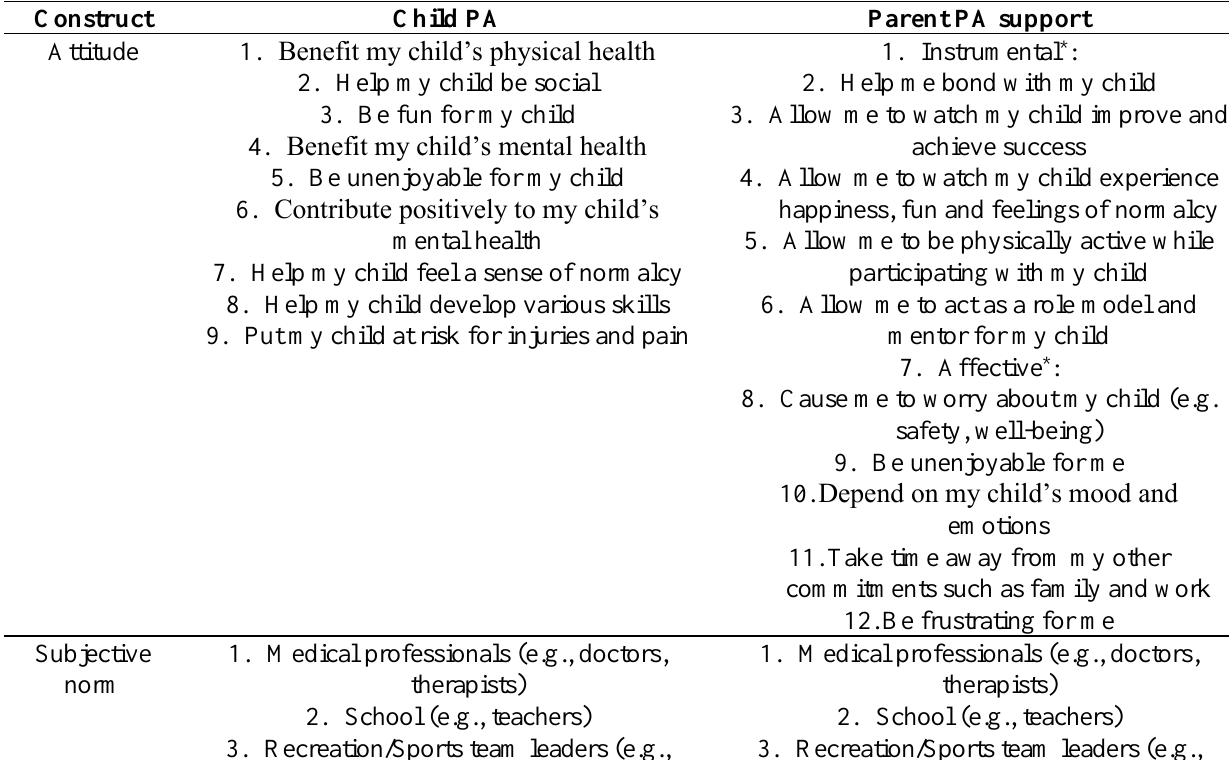
Table 2 . Theory of planned behaviour (i.e., pre-intention) beliefs elicited after content analysis